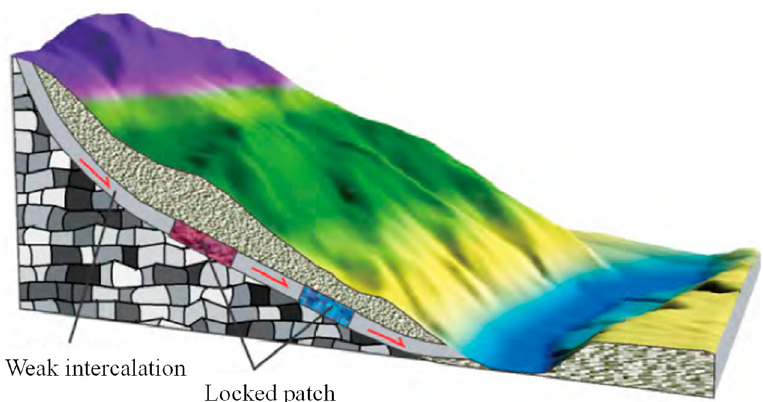
Figure 1. Schematic of the rock slope with locked patches (Reprinted with permission from [23], 2021, Chinese Journal of Geophysics).